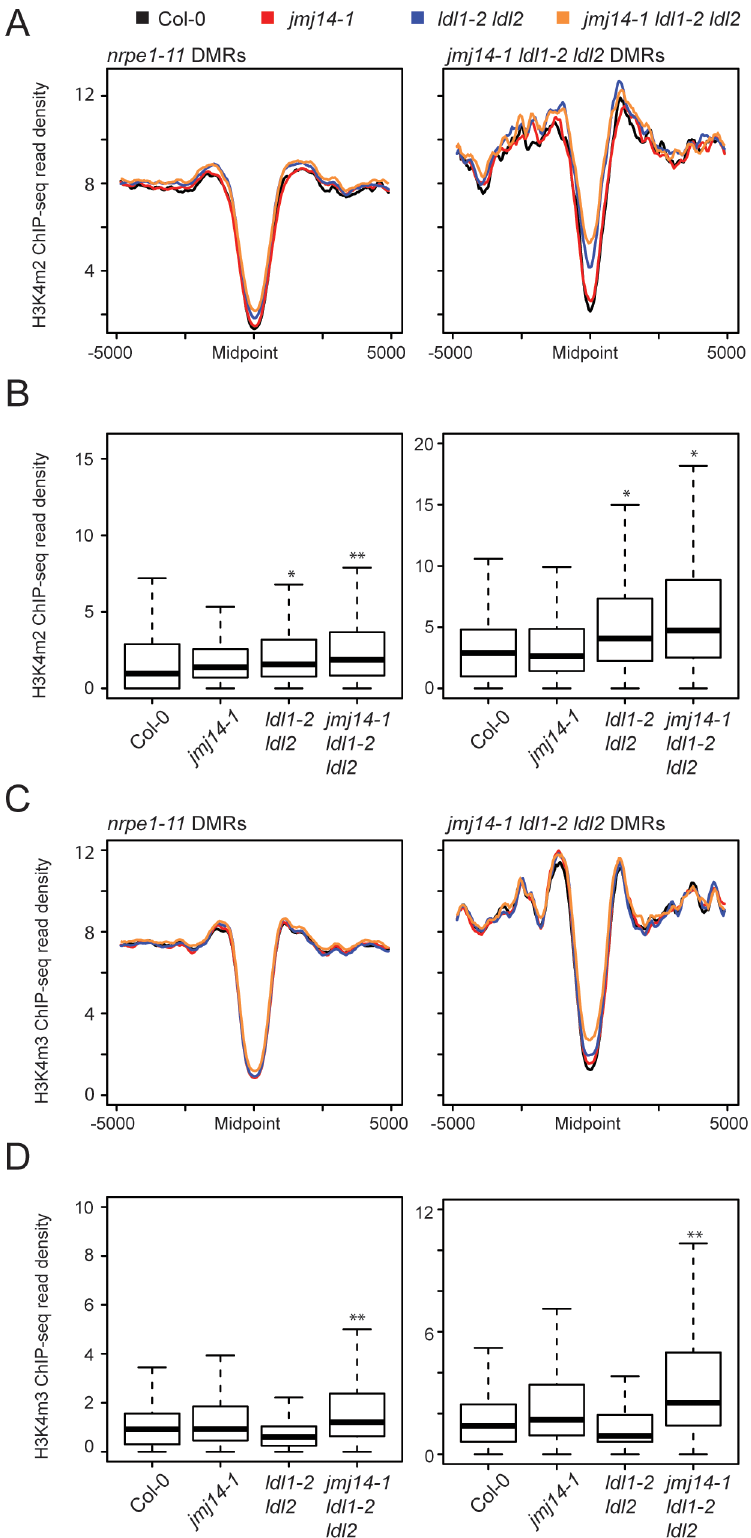
Figure 3. Global H3K4m2/m3 ChIP analysis. Metaplots (A) and boxplots (B) of H3Km2 ChIP-seq read density (RPKM) over DMR groups in demethylasemutantgenotypes.Forboxplots, DMRswere consideredasthe1000 bpregionextending + / 2 500 bp from the DMRmidpoint. * indicates a significant gain in read density for a given library relative to wild type (P , 1e-15, Mann-Whitney U Test) and ** indicates a gain in read density relative to all other libraries including wild type (P , 1e-15, Mann-Whitney U Test). (C) and (D) present similar analyses for H3K4m3 ChIP-seq libraries.